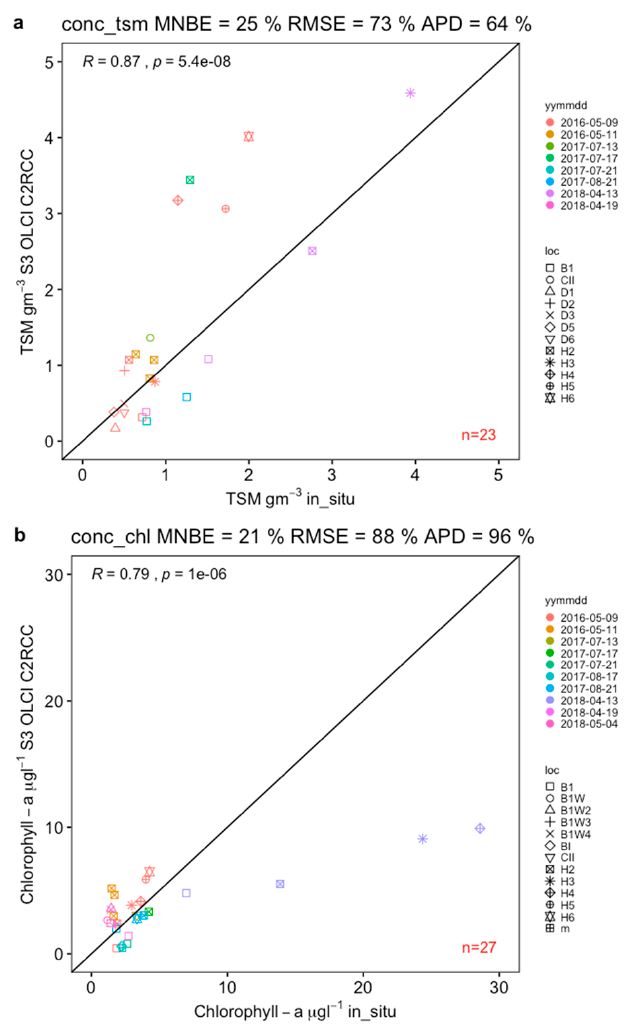
Figure 5. Concentration of ( a ) Total Suspended Matter (conc_tsm) and ( b ) Chlorophyll-a (conc_chl) derived from S3A OLCI data using C2RCC plotted again in situ concentrations.